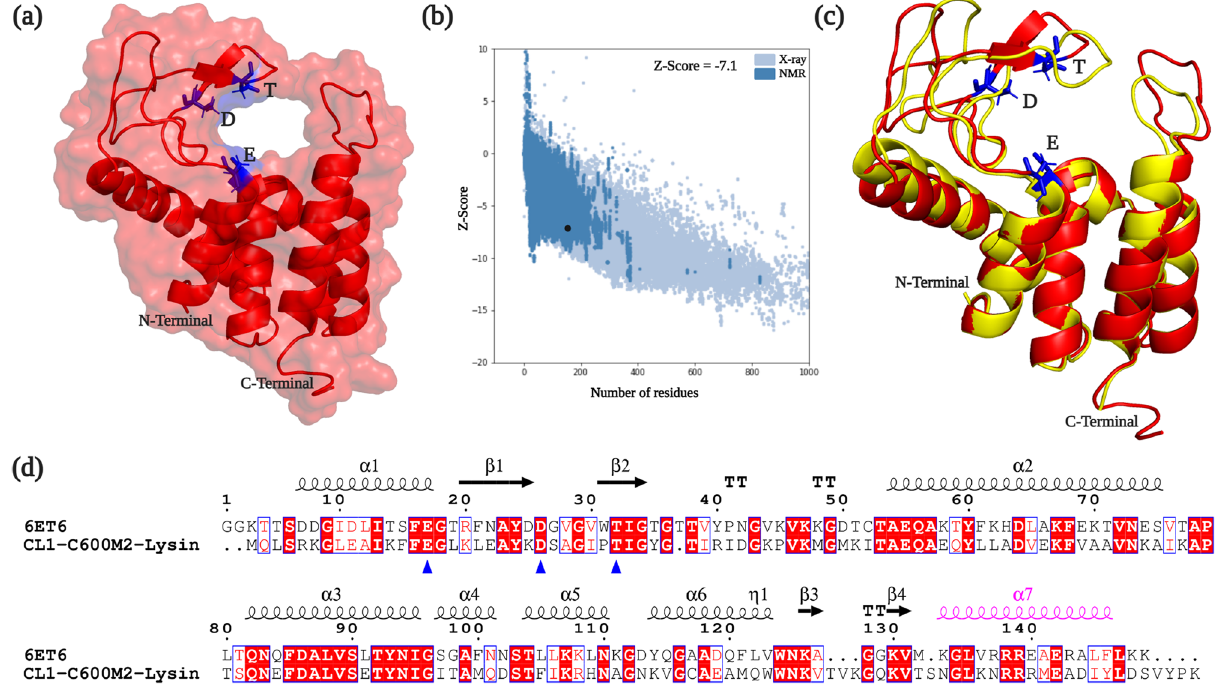
Figure 2. Sequential and Structural analysis: ( a ) three-dimensional CL1-C600M2-lysin modelled structure predicted by I-TASSER with labelled N and C-terminal region along with the catalytic triad Glu(E)-Asp(D)- Thr(T) represented as blue sticks. ( b ) Z-score plot generated by ProSA for predicted model quality assessment. ( c ) Superposition of CL1-C600M2-lysin (Red) with AcLys (PDB Code: 6ET6, Yellow). The catalytic triad is represented as blue sticks and labelled. ( d ) Multiple sequence alignment of AcLys (PDB Code: 6ET6) and CL1-C600M2-lysin. The catalytic triad is marked by blue triangles and the C-terminal α-helix enriched with positively charged residues is highlighted in